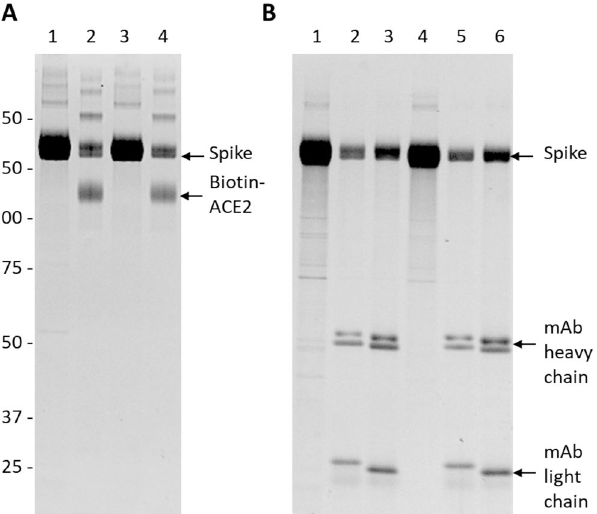
Figure 1. SDS gel analysis of the SARS-CoV-2 S proteins interacting with other proteins. ( A ) Binding of the S to the biotinylated ACE2. lane 1: S-614D; lane 2: S-614D + ACE2; lane 3: S-614G; lane 4: S-614G + ACE2. ( B ) Binding of the S to monoclonal antibodies. Lane 1–6: S-614D, S-614D + 3G7, S-614D + 3A2, S-614G, S-614G + 3G7, and S-614G + 3A2. The gels were run under reduced condition and visualized with SYPRO Ruby